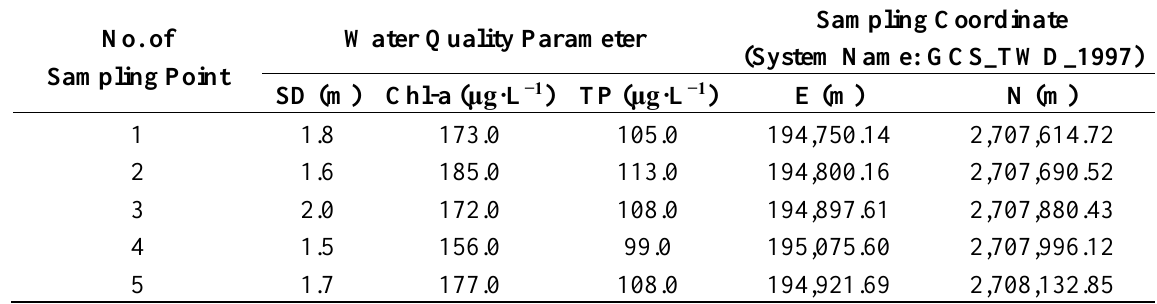
Table 3. Examination results of measurement, in situ , on 24 November 2014 for Tain-Pu